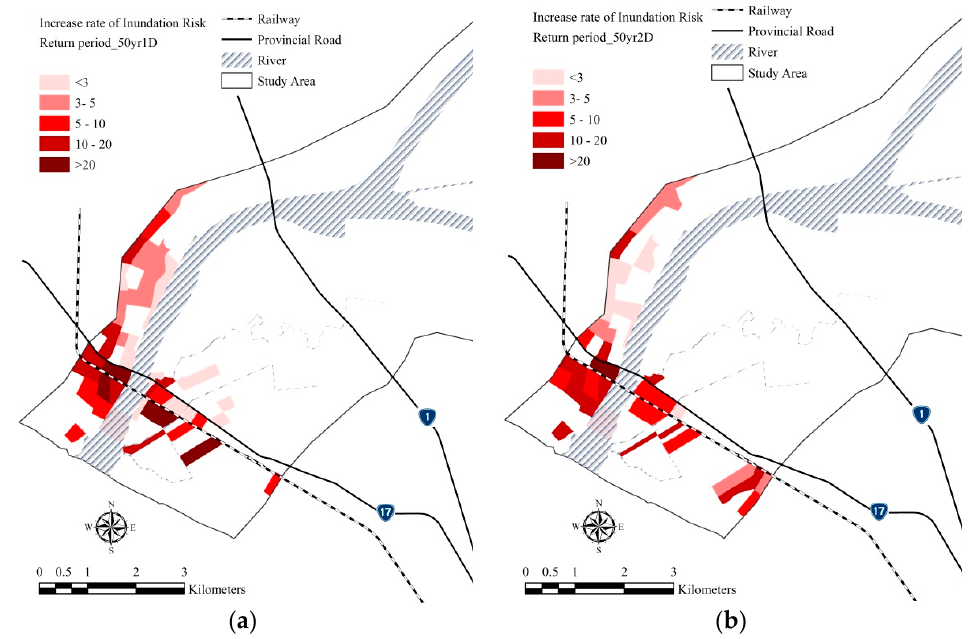
Figure 14. ( a ) Distribution map of inundation risk increase after land subsidence for a one-day storm under a 50-year return period; ( b ) Distribution map of inundation risk increase after l and subsidence for a two-day storm under a 50-year return period.